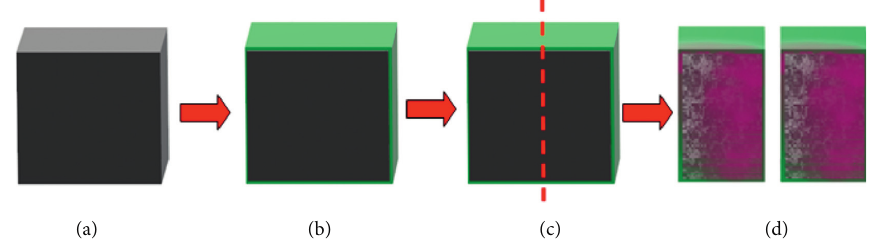
Figure 1: Carbonation test setup: (a) uncoated concrete surfaces; (b) all surfaces, except one, are coated; (c) specimens are sectioned into